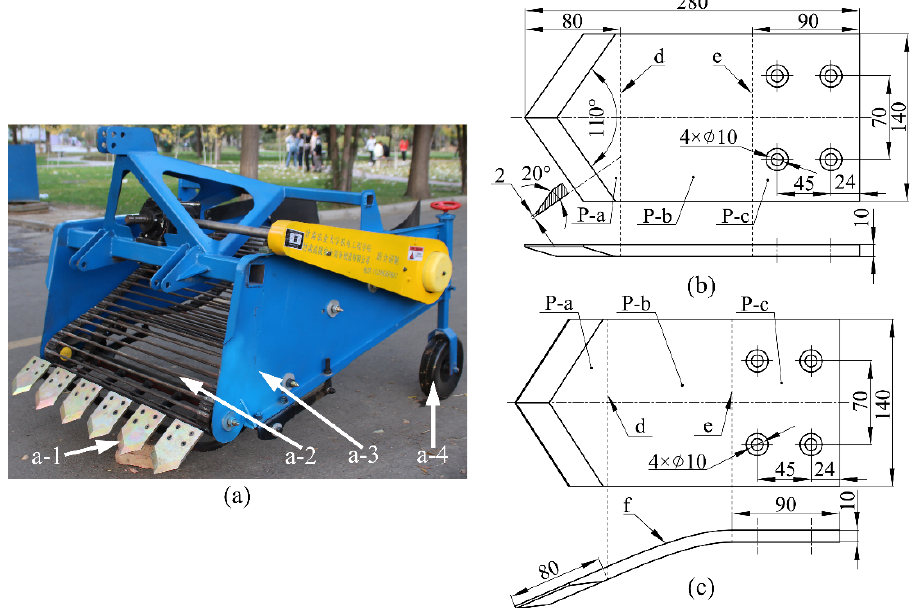
Figure 2. Photo of 4U-110 potato harvester ( a ) and detail drawing of DZ (( b ), dimensions in mm) and YS (( c ), dimensions in mm). (a-1) Potato digging shovel, (a-2) conveying and separating device, (a-3) harvester’s frame and (a-4) ground wheel.